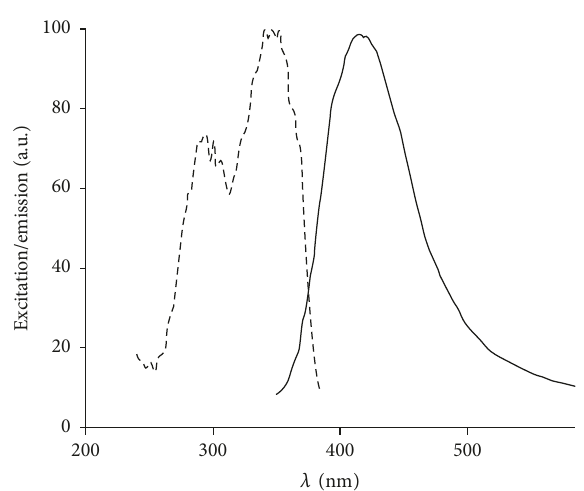
Figure 3: The excitation (dashed line) and emission (solid line) spectra of compound 4b (a.u.: arbitrary units).